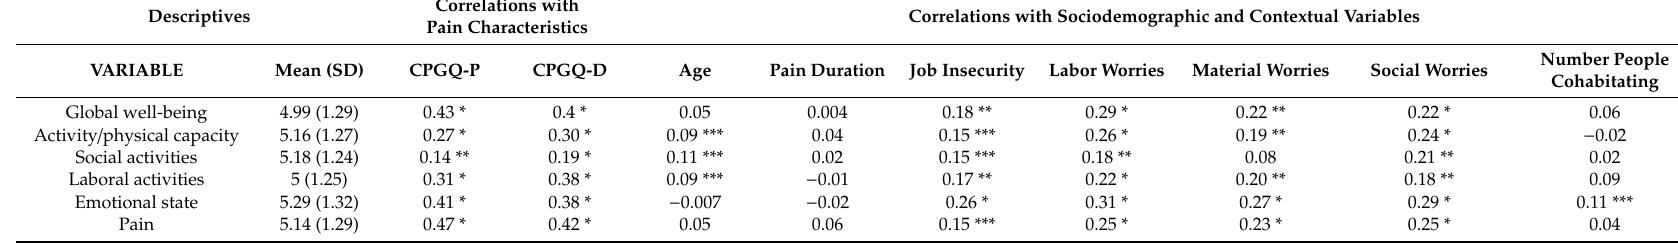
Table 3. Descriptives in Pain-Specific Impression of Change (PSIC) domains and global changes (Patient Global Impression of Change (PGIC)) and correlations between study